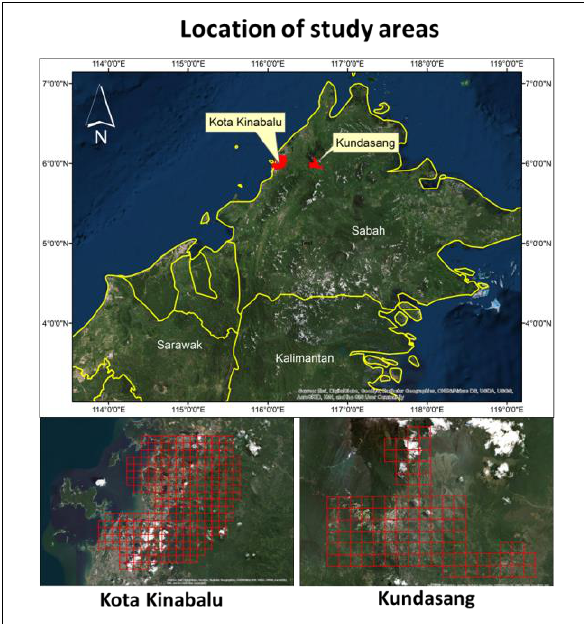
Figure 1. Location of the study